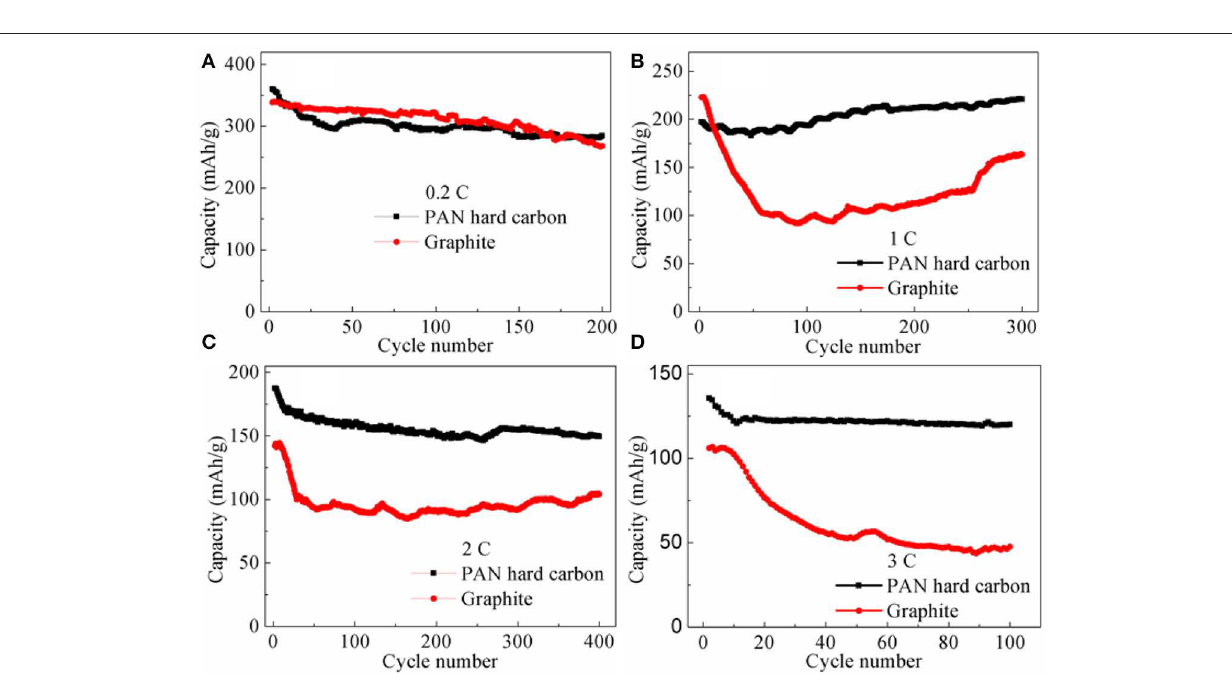
charge capacities are 320.1, 219.0, 212.9, and 123.5 mAh g − 1